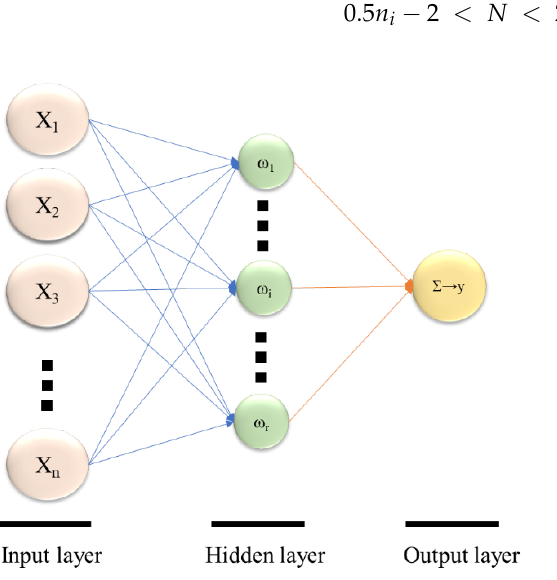
Figure 3. Structure of ANN model building.